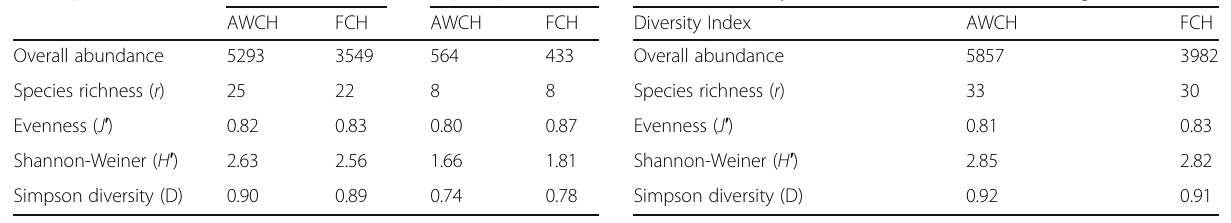
Table 5 Diversity indices of wild birds at Sharkia